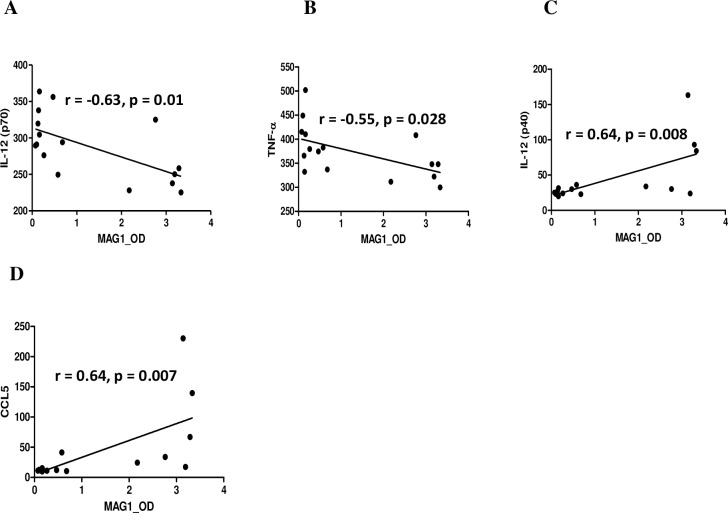
Correlations between brain cytokine concentrations and MAG1 antibody level.Five out of 23 cytokines differed significantly in concentrations between mice with high MAG1 levels and controls (ANOVA and Bonferroni correction). Spearman's correlation analysis was used to evaluate the relationship between the 5 cytokines and MAG1 antibody level. The MAG1 antibody levels inversely correlated with levels of (A) IL-12p70 and (B) TNF-α, but positively correlated with (C) IL-12(p40) and (D) CCL5.